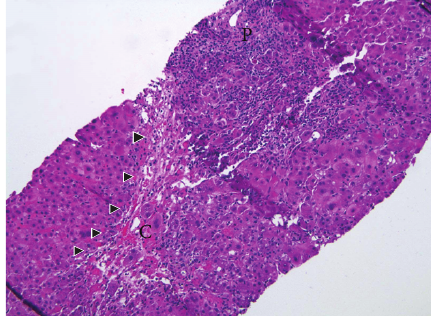
Figure 1: The liver biopsy showed severe portal and lobular hepatitis with perivenular and bridging necrosis (arrow heads) (H&E stain, original magnification 100x). P: portal tracts, C: central vein.